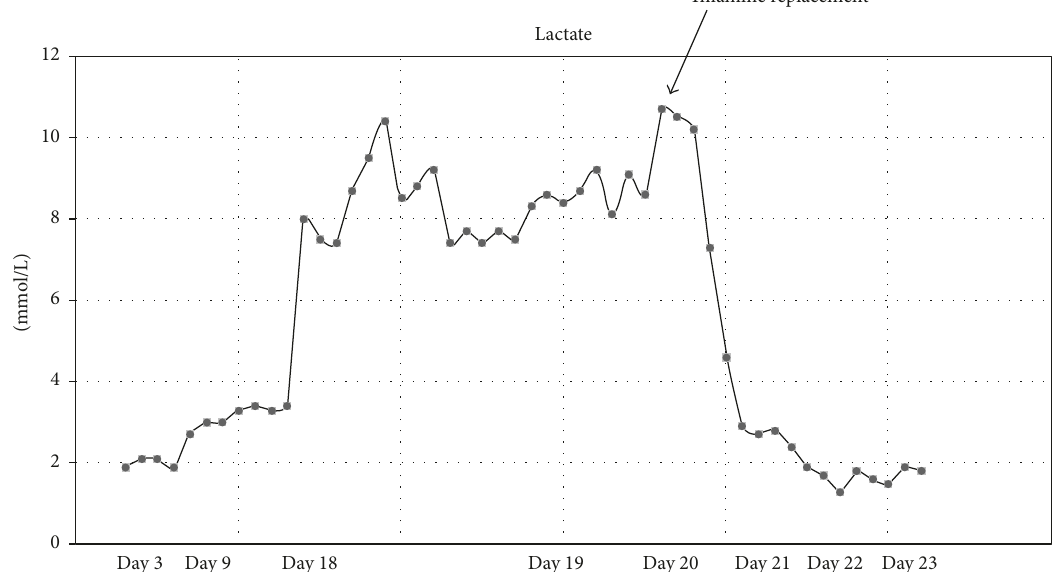
Figure 1: Lactate trend following initiation of thiamine replacement in our critically ill